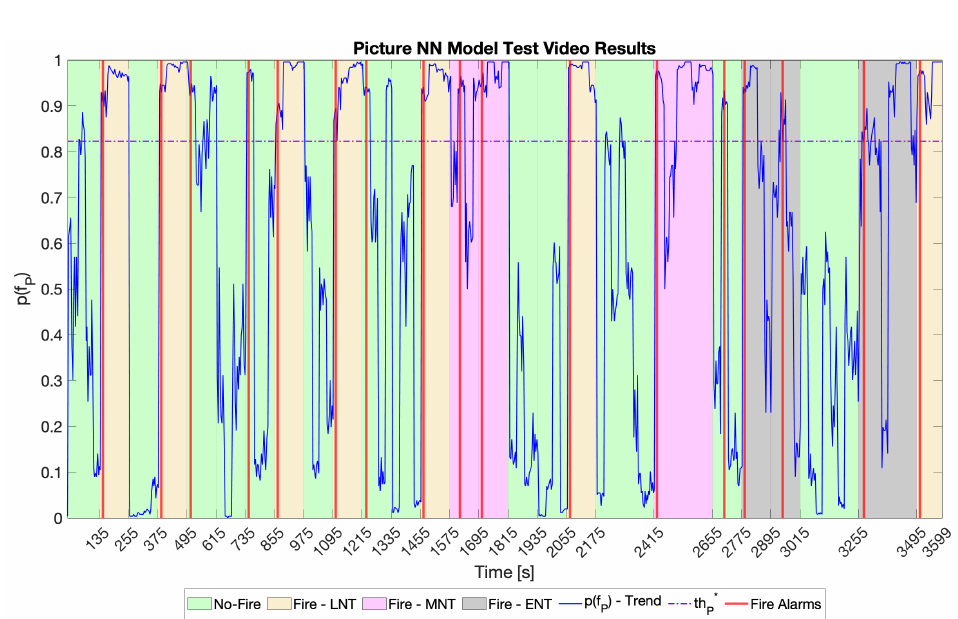
Figure 8. Picture NN model results on the test video. The green areas represent input samples belonging to the class“No-Fire”. The yellow, pink, and grey areas represent input samples belonging to the “Fire” class in LNT, MNT, and ENT, respectively. The solid blue line stands for the trend of p ( f P ) , while the dash-dotted line represents th P ∗ . Finally, the vertical red lines mark the instants at which the picture NN model signalled a fire